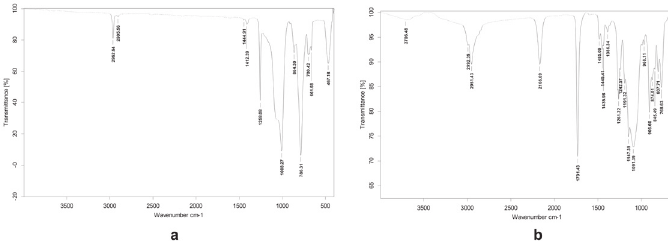
Figure 4- Fourier Transform Infrared spectrometer (FTIR) spectra of the adhesive (a) and the soft liners (b)